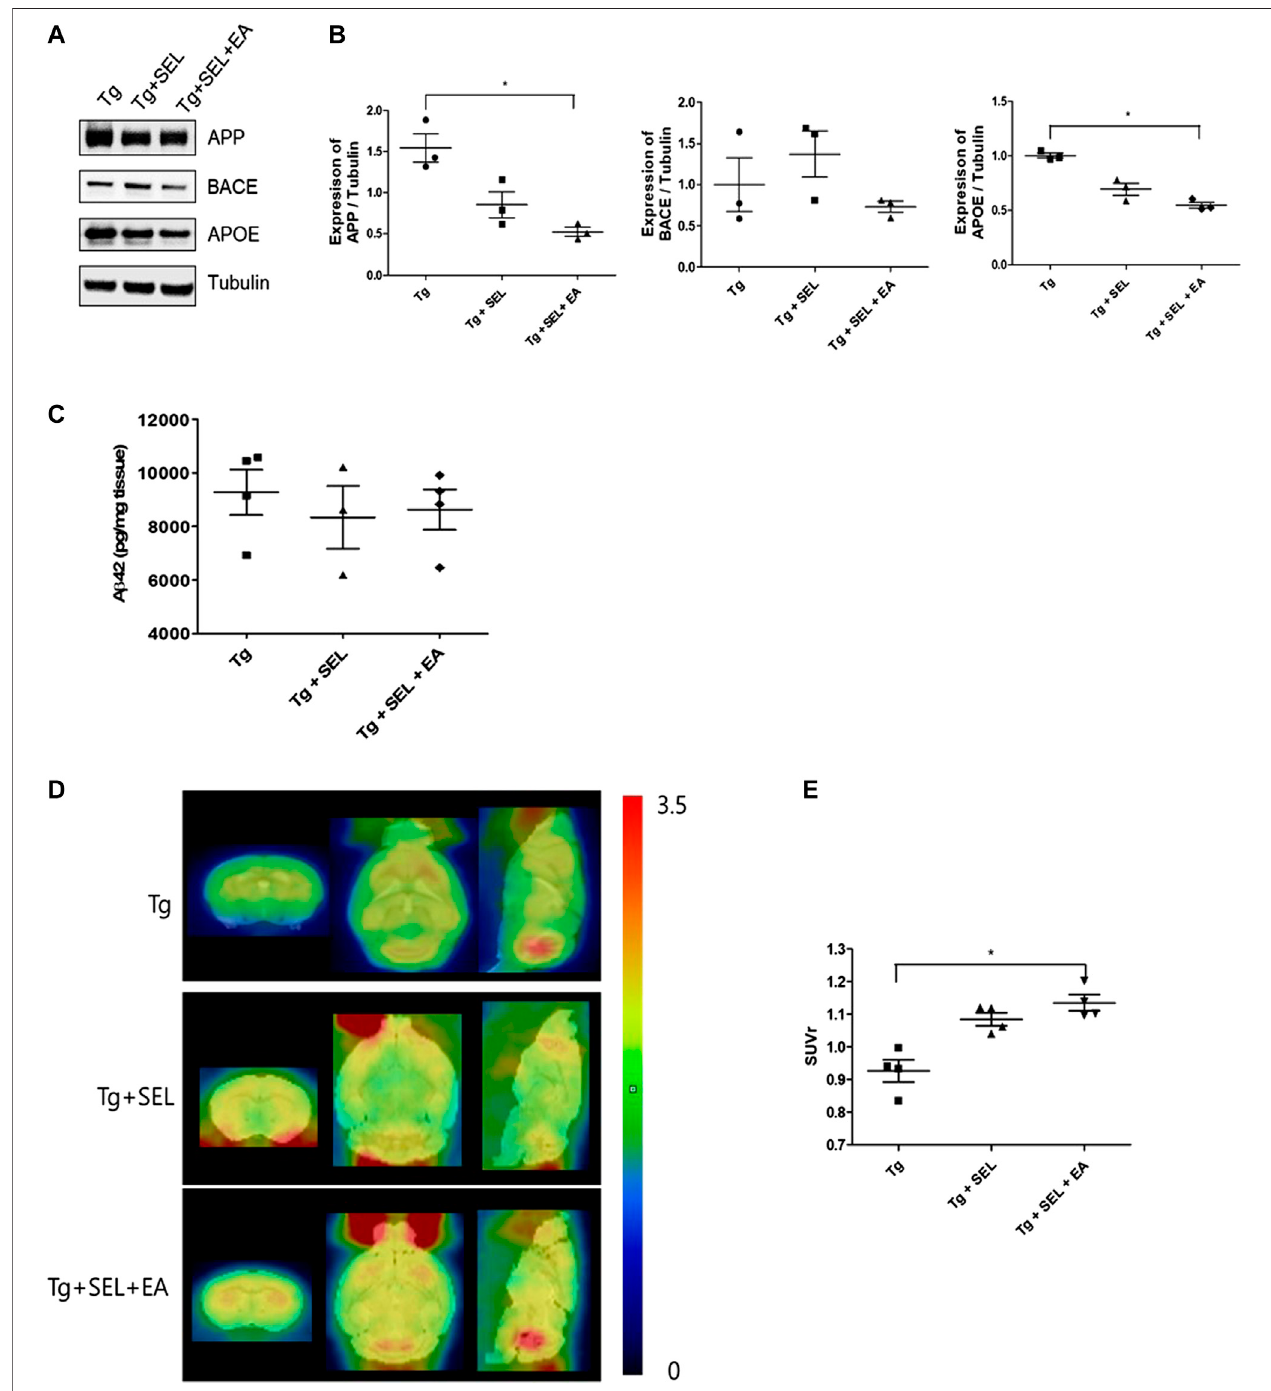
FIGURE 5 | Means ± SEM of APP, BACE, APOE, and A β in the prefrontal cortex of 5XFAD mice in Tg, Tg + SEL, and Tg + SEL + EA groups. (A) Representative immunoblotimagesofAPP,BACE,andAPOEproteinexpression. (B) Quanti fi cationoftheexpressionofAPP,BACE,andAPOElevels(n (cid:2) 3/group). (C) InsolubleA β 1-42 levels demonstrated on ELISA (n (cid:2) 3 – 4/group). (D) Representative microPET images. (E) Quantitative analysis of ROI-based 18 F-FDG uptake (SUV) in the frontal cortex (n (cid:2) 4). Statistical analysis of the immuno blots and SUV were analyzed using Kruskal – Wallis test and Dunn ’ s multiple comparison test with p values < 0.05 considered statistically signi fi cant. SEM, standard error of mean; A β , β -amyloid protein; APP, A β precursor protein; BACE, β -secretase; APOE, apolipoprotein E; ELISA, Enzyme-Linked Immunosorbent Assays; ROI, region of interest; Tg, 5XFAD mice group; Tg + SEL, selegiline-treated 5XFAD mice group; and Tg + SEL + EA, 5XFAD mice treated with selegiline combined with